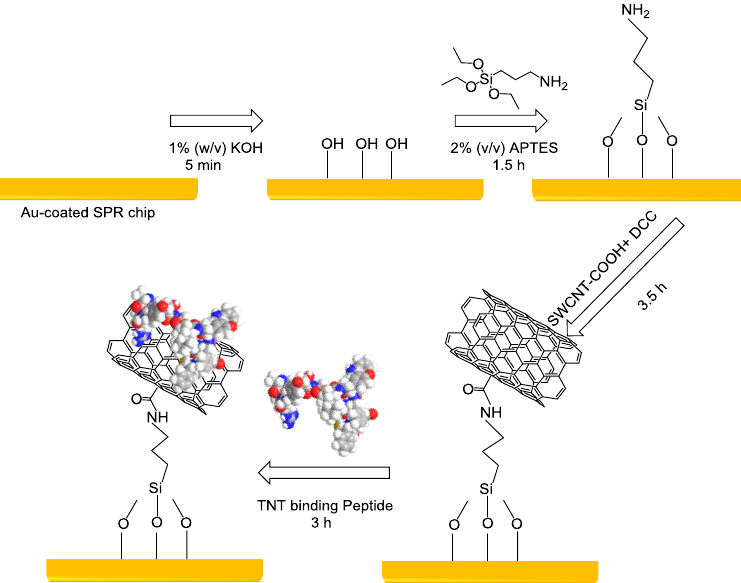
Figure 1. A schematic illustration of the immobilization procedure of the 2,4,6-trinitrotoluene (TNT)-binding peptide TNTHCDR3 on the surface of a single-walled carbon nanotube (SWCNT)-based surface plasmon resonance (SPR) gold-coated